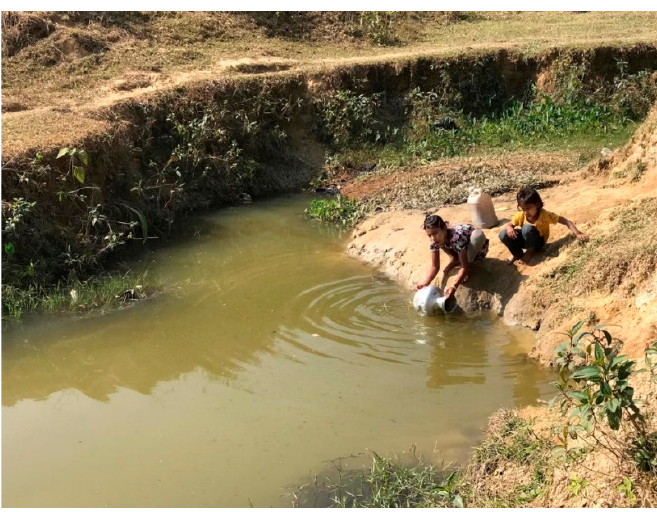
Figure 2. Water source in Rohingya refugee camp (photo was taken with Permission).